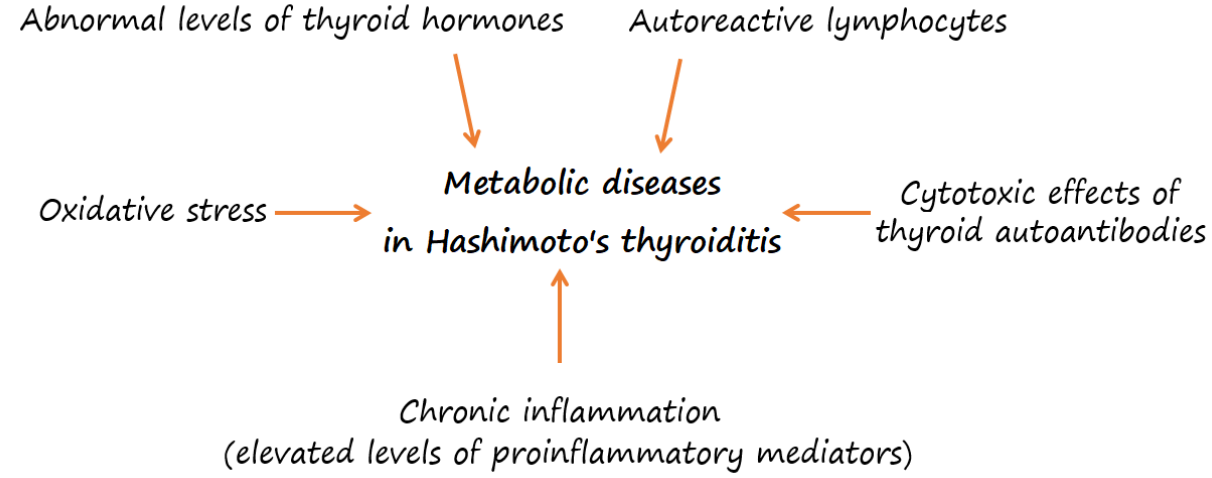
Figure 1. Factors influencing the increased risk of metabolic disorders in Hashimoto’s thyroiditis.